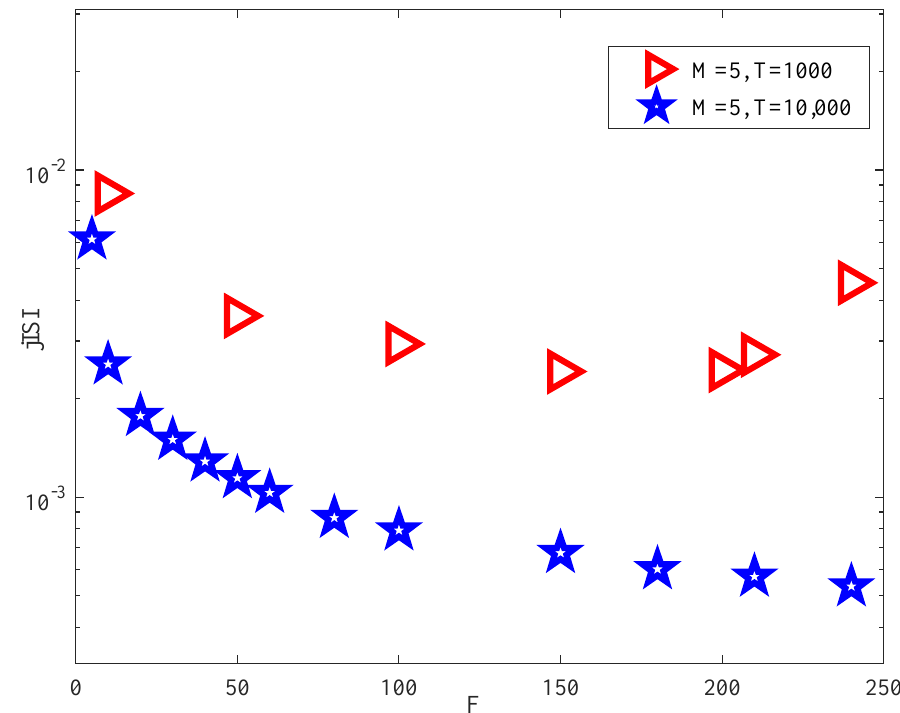
Figure 6. Performance comparison of IVA with different sample